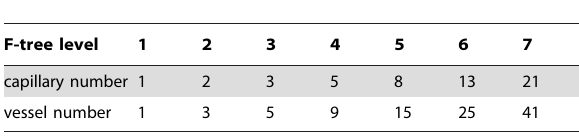
Table 2. Vessel numbers and capillary numbers of M-trees.